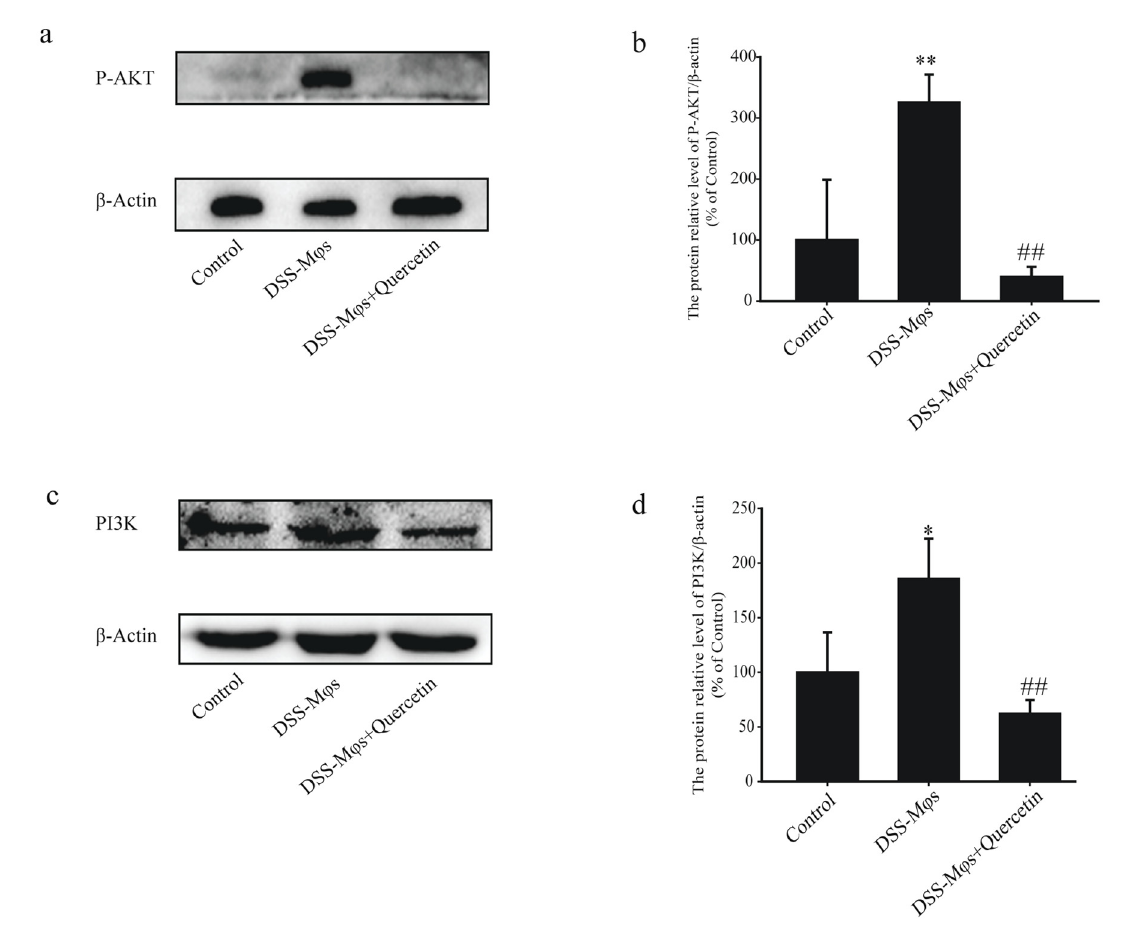
Figure 8. Quercetin inhibited the activation of the PI3K-AKT signaling pathway to exert an anti-colitis effect in vitro . ( a – d ) Western blotting analysis of phosphorylated (P)-AKT and PI3K expression in extracts of mouse colon epithelial cells. * p < 0.05, ** p < 0.01 compared with the control group; # p < 0.05, ## p < 0.01 compared with the DSS group.